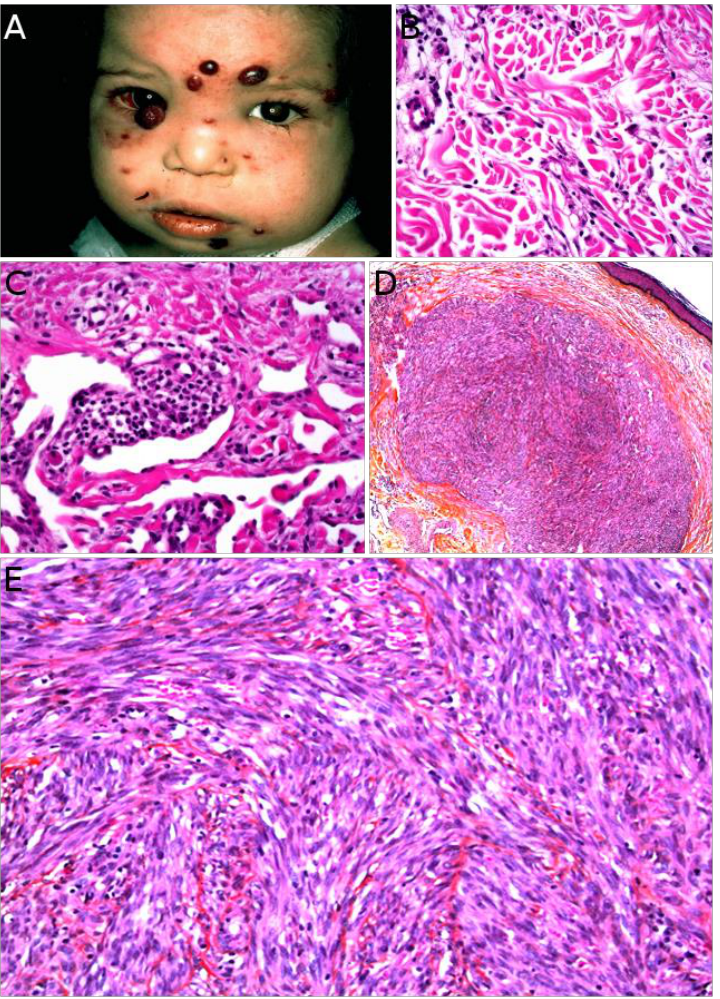
Figure 11. Kaposi sarcoma: ( A ) Multiple vascular nodules on the face of a child with Wiscott–Aldrich syndrome; ( B ) rare spindle cells infiltrating between the collagen bundles in a clinically macular lesion (×100); ( C ) irregular vascular spaces and lymphocytic infiltrate in a clinically papular lesion (×100); ( D ) nodular spindle-cell proliferation in a clinically nodular lesion (×25); ( E ) spindle-cell proliferation admixed with lymphocytes in a nodular stage lesion (×200).